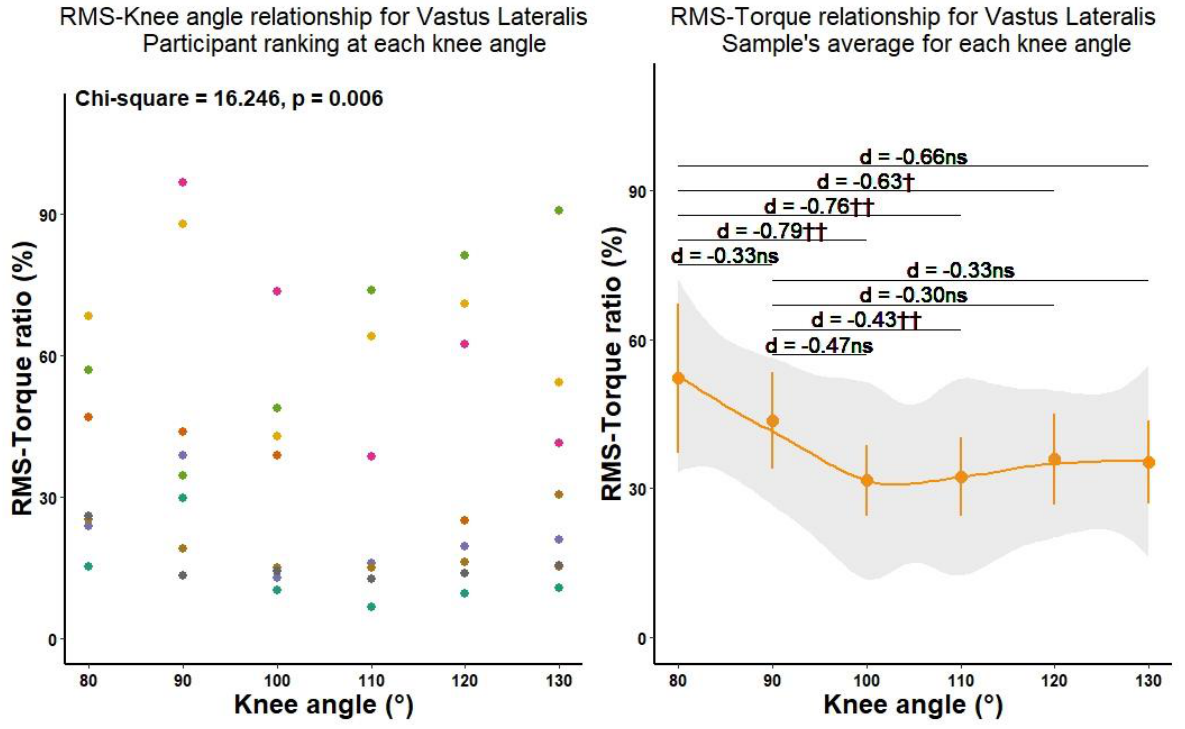
Figure 3. The vastus lateralis RMS—F ration at different knee joint angles. † Significant by Friedman test at p < 0.05, †† Significant by Friedman test at p < 0.01. Table 3. Conover post hoc test for ∆ VL RMS